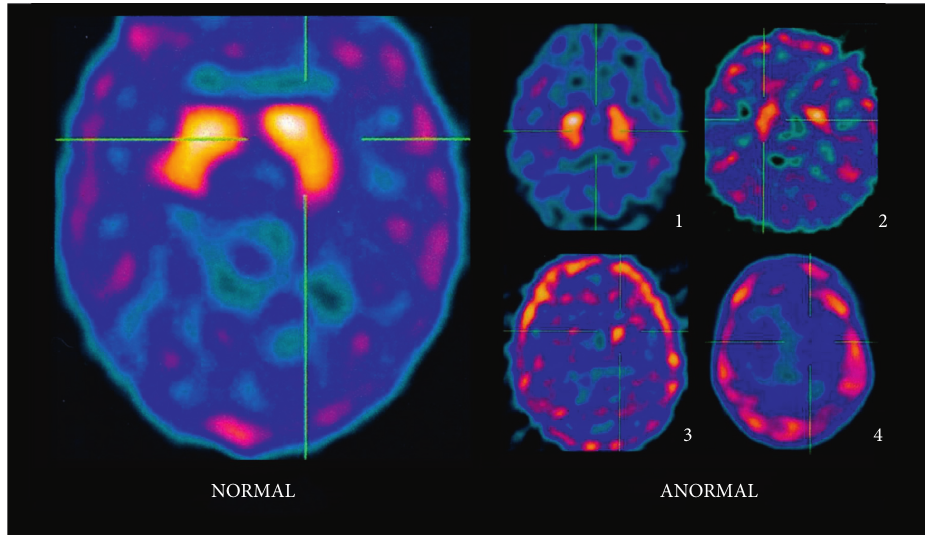
Figure 1: Degrees of involvement according to radiopharmaceutical uptake in cerebral SPECT with 99m